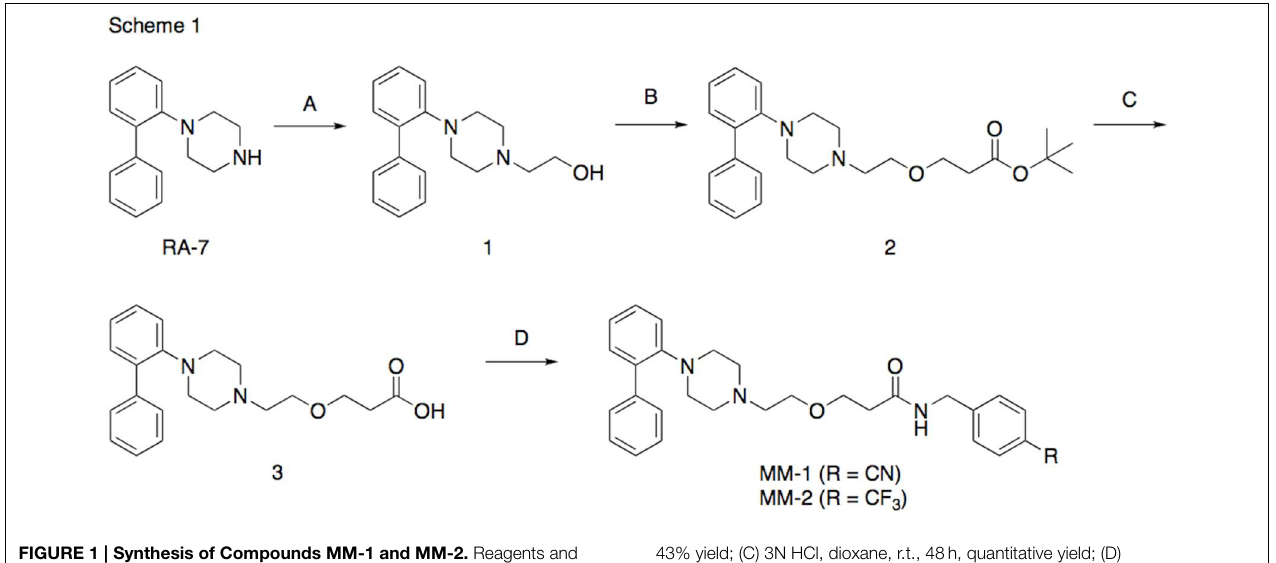
FIGURE 1 | Synthesis of Compounds MM-1 and MM-2. Reagents and Conditions: (A) 2-bromoethanol, K 2 CO 3 , KI, acetonitrile, reflux overnight, 82% yield; (B) NaH, t -butyl acrylate, anhydrous THF, 0 ◦ C to r.t., 20–22h,